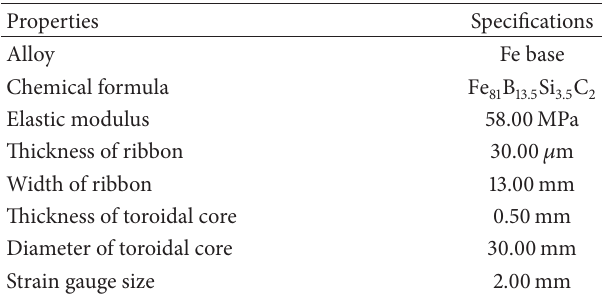
Table 1: Selected properties of Fe based amorphous ribbon, which were used to construct toroidal transducer core.